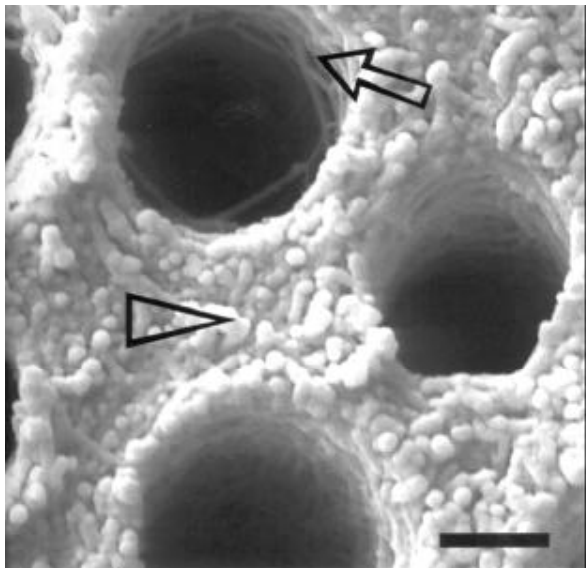
FIGURE 4 - Surface view of old dentin (50 years old) etched with 36% phosphoric acid for 15 seconds. Note the collagen fibrils exposed (arrow) and collagen fibers embedded in mineralized areas (arrowhead) (Bar = 1 µm / 5,000 X)